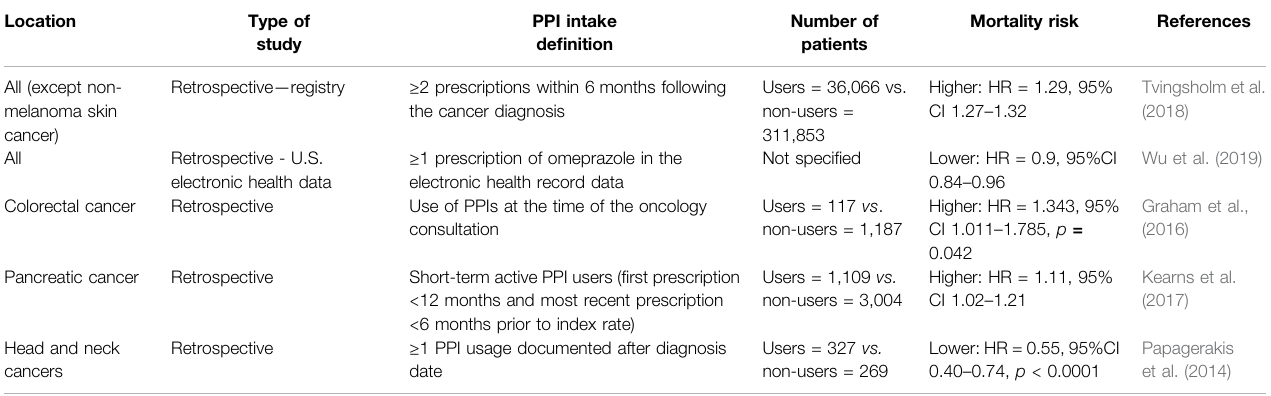
TABLE 1 | Main studies on cancer-speci fi c mortality among proton pump inhibitor users.